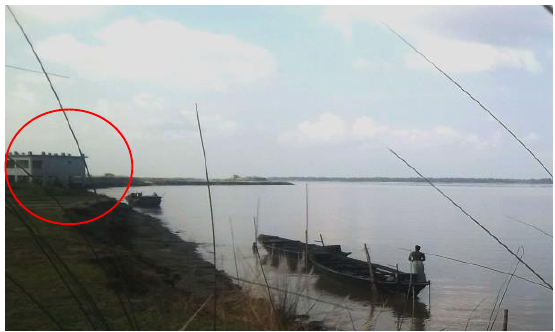
Figure 8.Govt. Primary School at Belgacha facing serious threat of bank erosion .